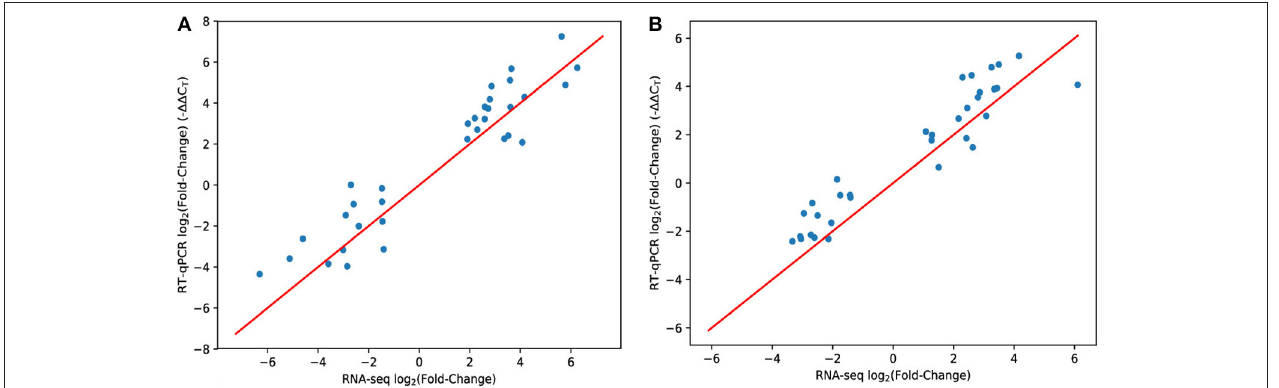
FIGURE 1 | Comparison of RNA-seq and RT-qPCR methodologies. Each data point represents a single gene. The x-axis shows the mean expression fold change of each gene in hypoxia (A) or PBS nutrient starvation (B) relative to 7H9 using the RNA-seq methodology (and inferred with DESeq2). The y-axis is the same measurement (mean 11 C T ) but using the RT-qPCR methodology to measure gene expression. The red line is y = x. Genes were hand-selected based on the RNA-seq data.